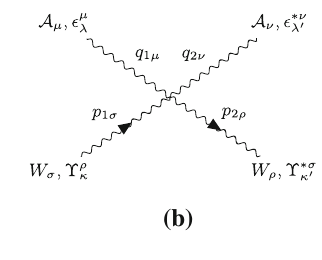
Fig. 33 Feynman rules for the three- and four-point couplings of the spin-1 field and gauge field in the Lee–Yang model. Wavy lines with arrows indicate the vector monopole field, while wavy lines without arrows represent the photon. The corresponding rules are given in